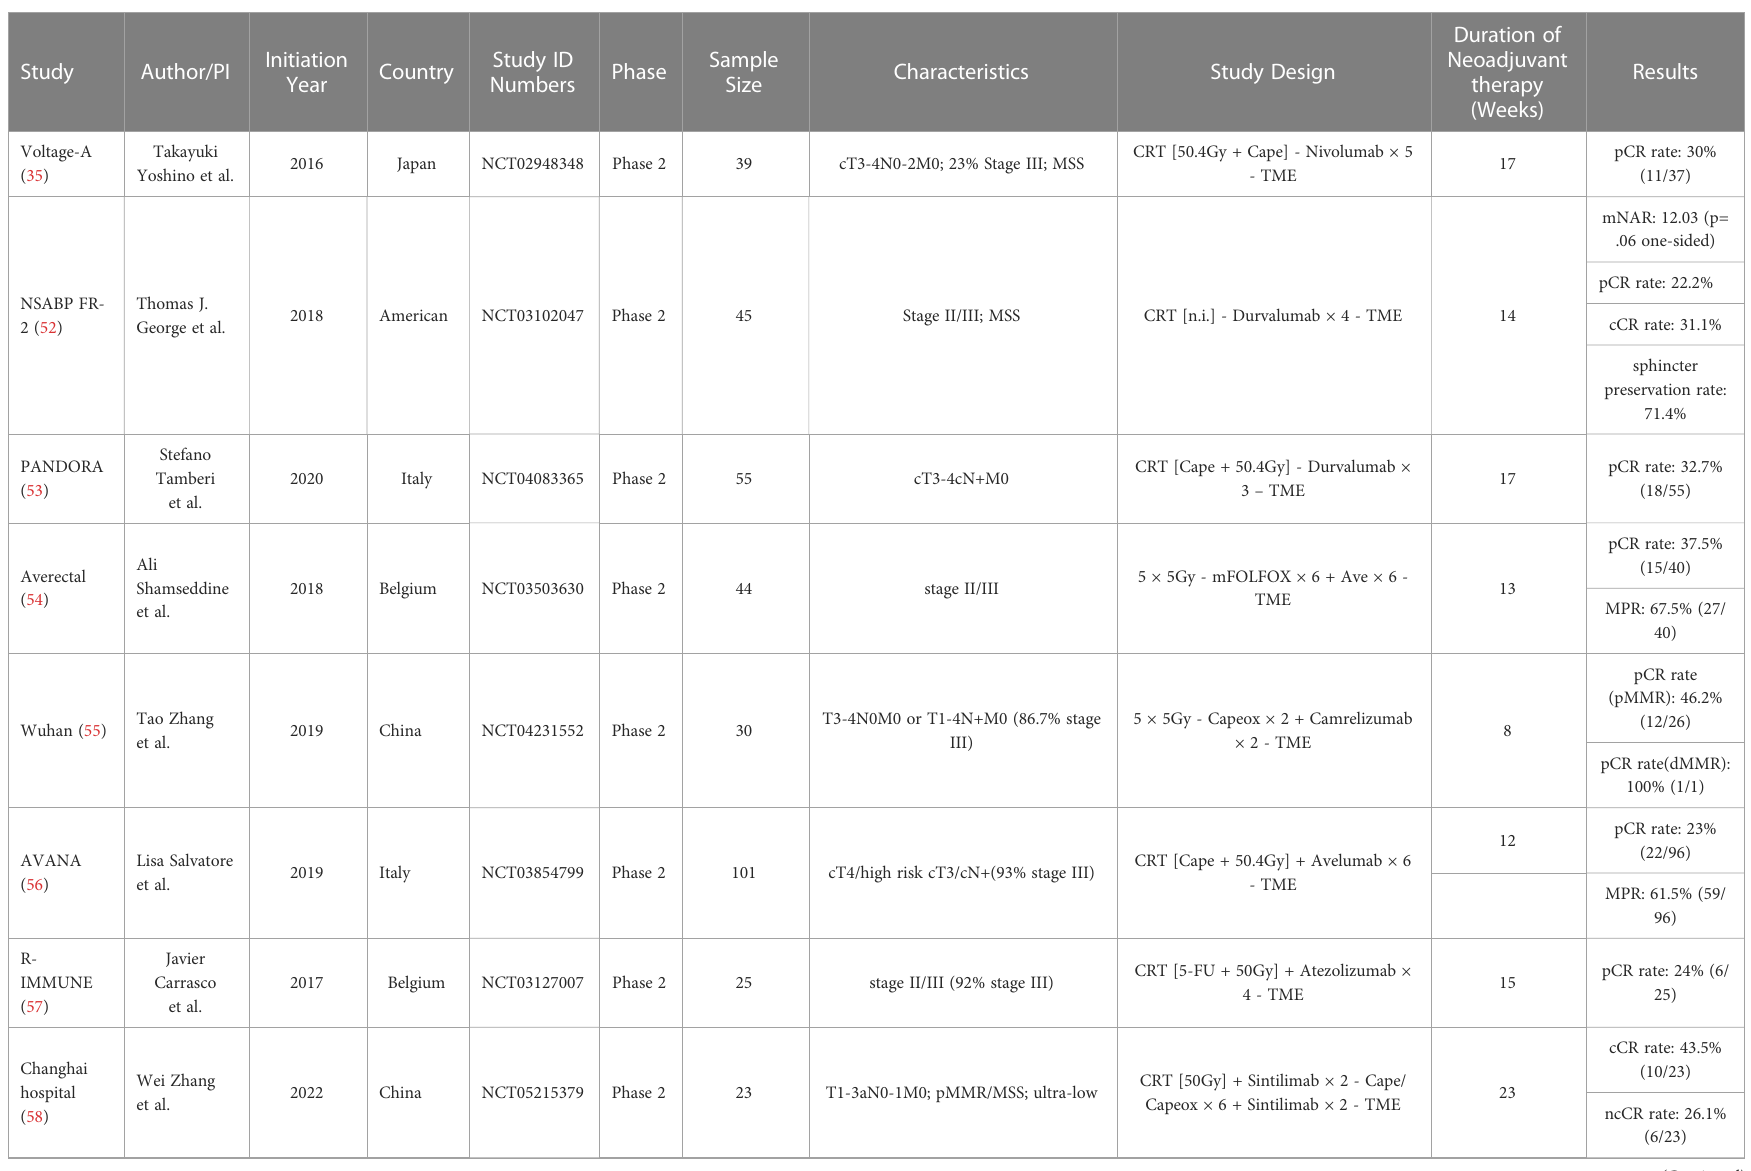
TABLE 2 Clinical trials of neoadjuvant chemoradiotherapy combined with PD-1/PD-L1 antibodies for